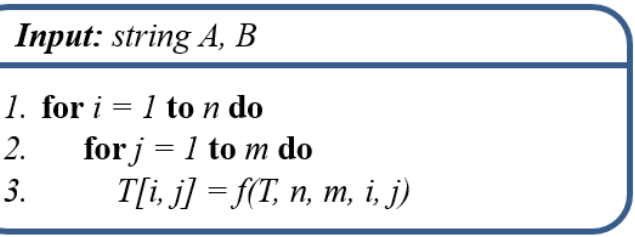
Figure 1. The general form of dynamic programming-based string similarity measures. source